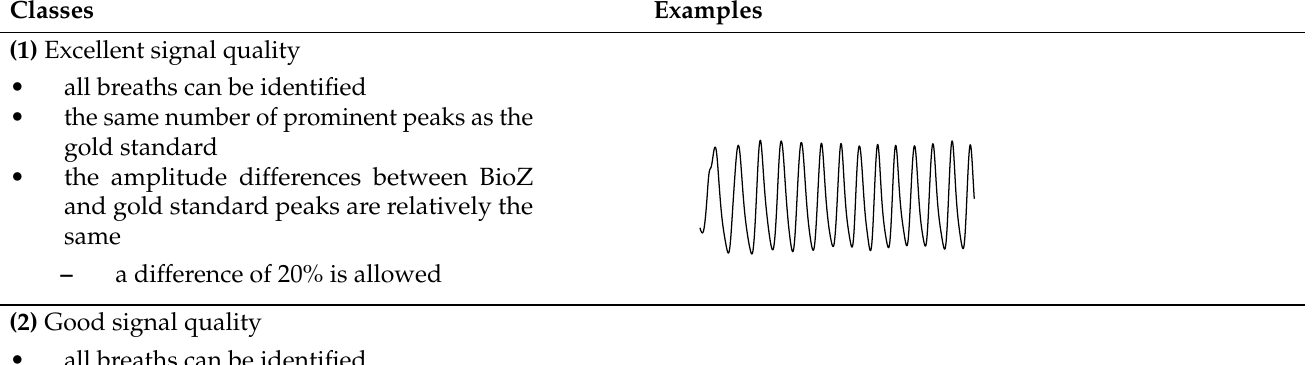
Table 2. Overview of the different class labels. Note that these rules were created for one-minute segments. Classes